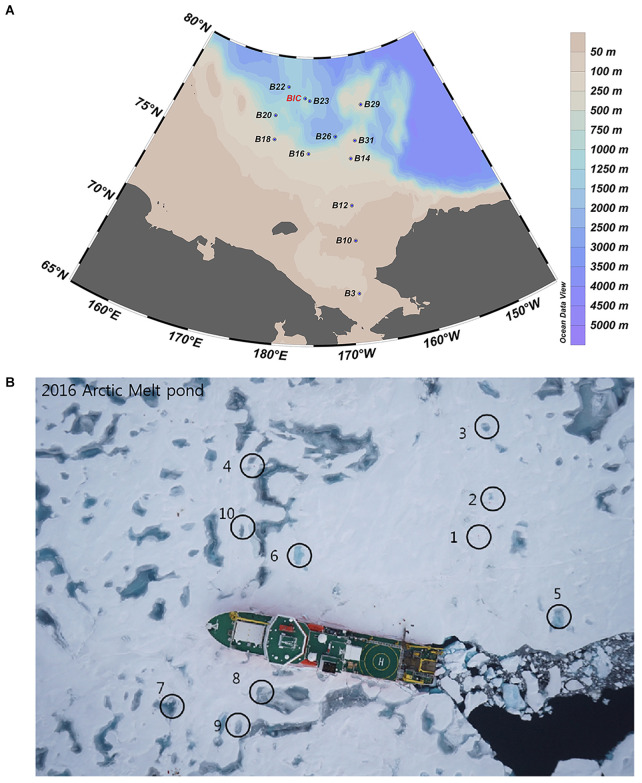
Sampling sites in the Arctic Ocean during the summer cruise of ARA07 conducted in 2016, showing the sea water (A) and melt pond (B) sites, respectively.